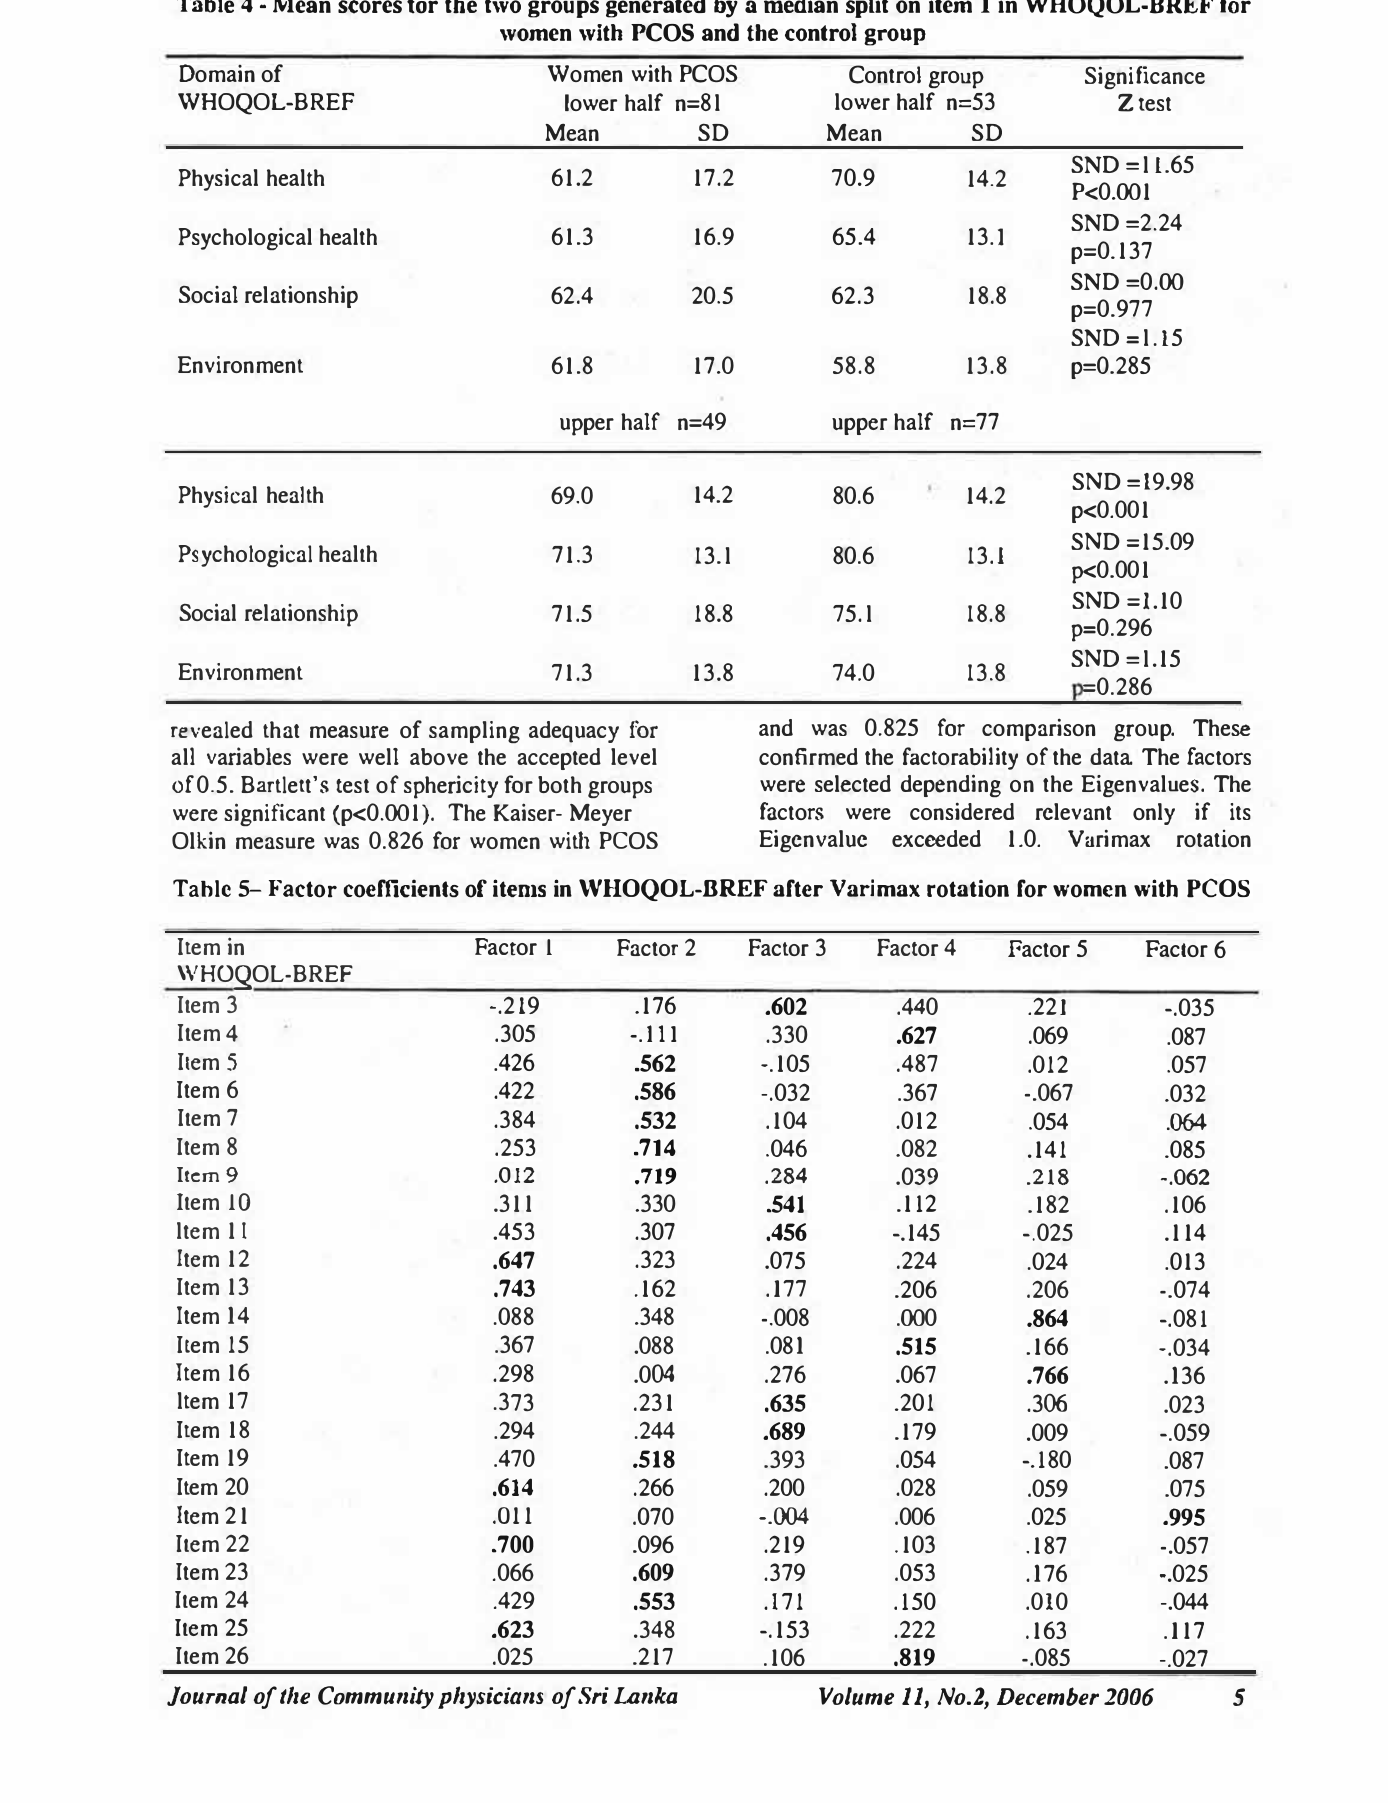
Table 4 · Mean scores for the two groups generated by a median split on item 1 in WHOQOL-BREF for women with PCOS and tbe control